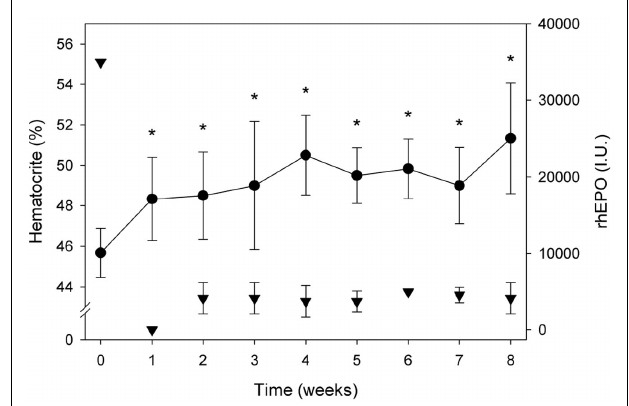
FIGURE 1 | Blood hematocrit (%) and rhEPO dosage over the 8week treatment period. Data are means ± SEM. Asterisk ∗ indicates significant difference pre vs. post, p <